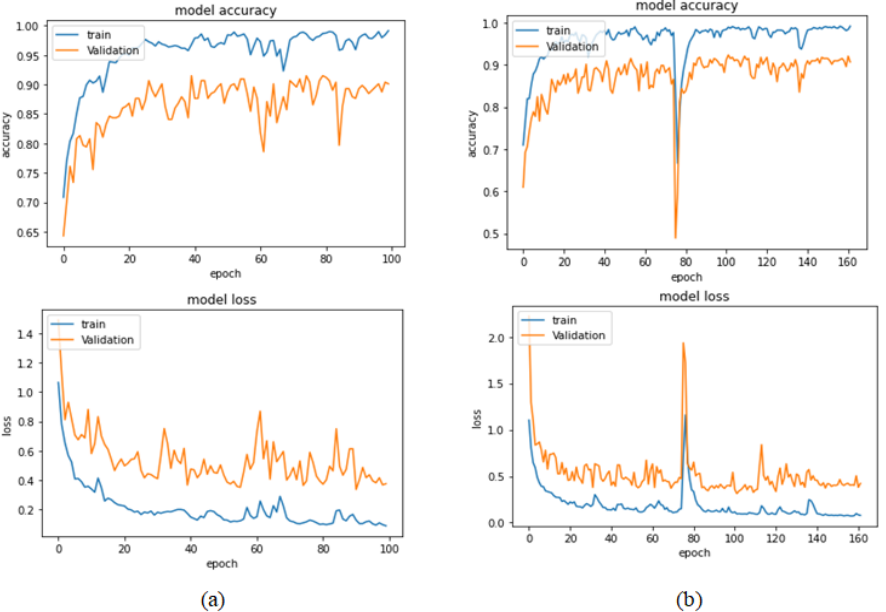
Figure 29. Learning curves for Xception at 0.0001 learning rate in 400× magnification-dependent multi-classification. ( a ) Accuracy and loss curves of Phase 1 of training. ( b ) Accuracy and loss curves of Phase 2 of training.